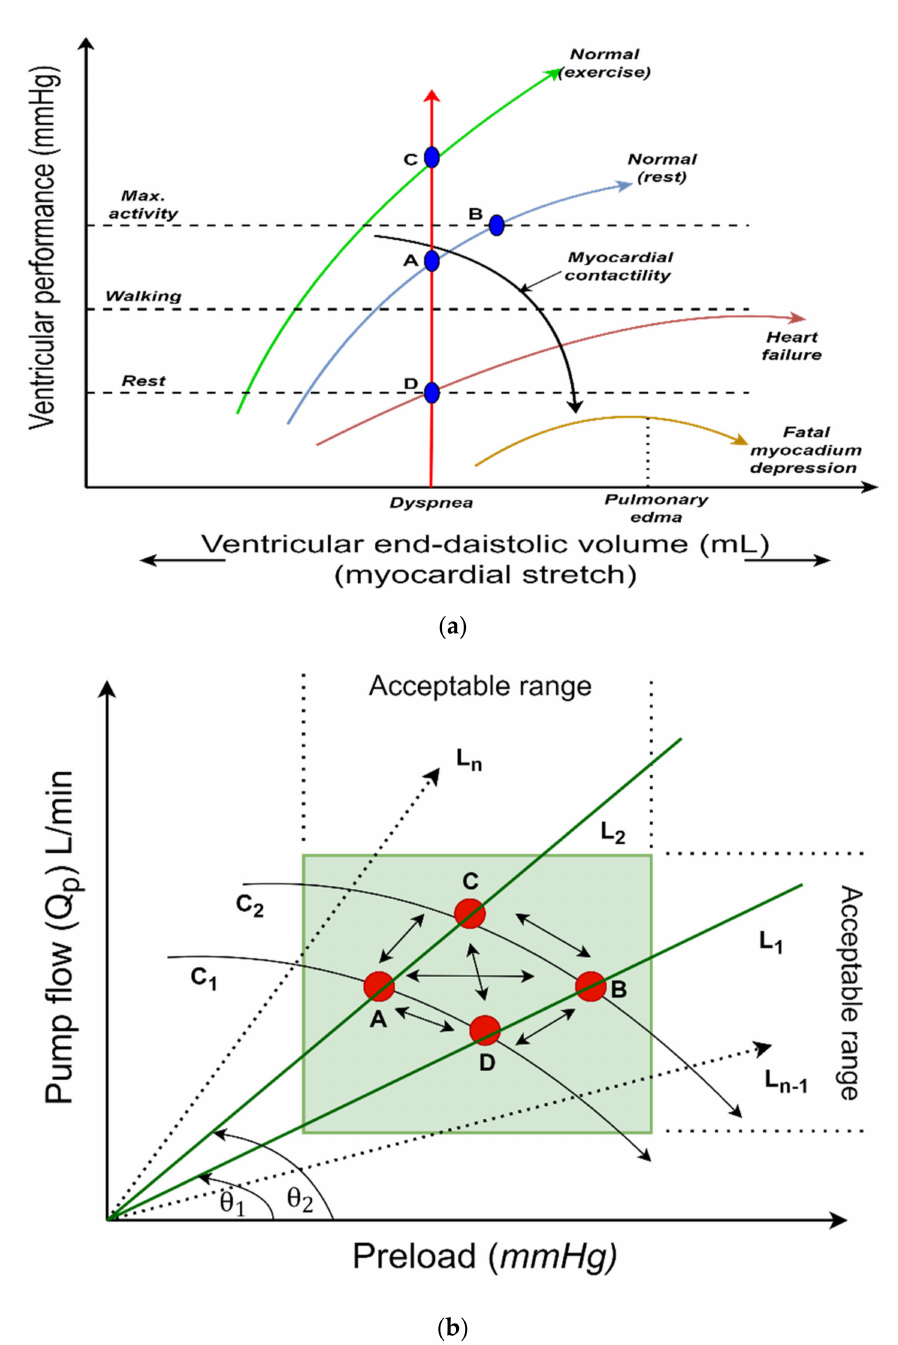
Figure 1. Physiological control method. ( a ) Cardiac function curves at different contractility condi- tions. ( b ) Preload control mechanism; A, B, C, D: operating points; L 1 , L 2 , L n , L n − 1 : preload control lines; C 1 , C 2 : flow preload curve; θ 1 , θ 2 :